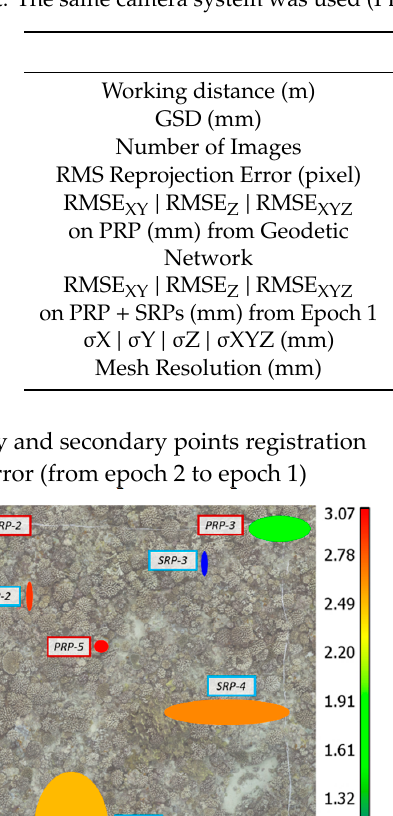
Table 9. Statistics from the photogrammetric processing for epoch 1 (2018) and epoch 2 (2019) on the same plot. The same camera system was used